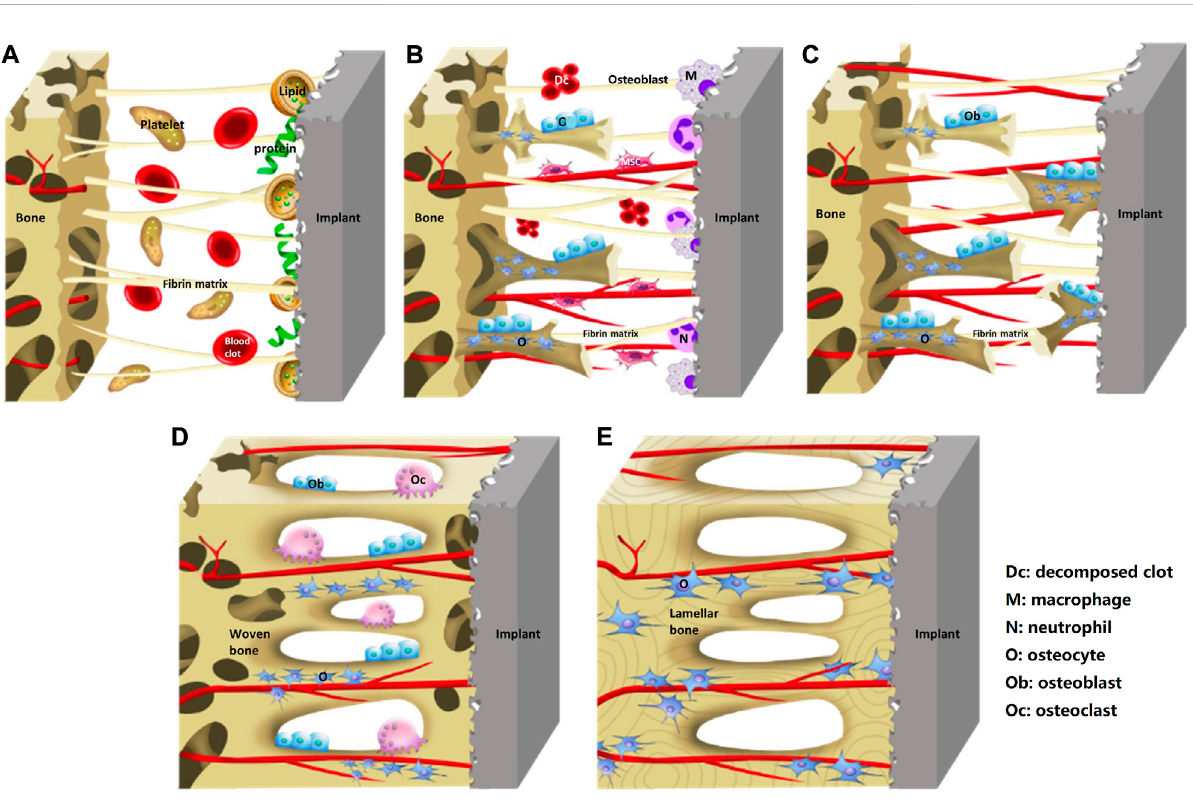
FIGURE 1 Schematic diagram of the process of implants osseointegration. (A) Blood clot and fi brin matrix formation. (B) Woven bone formation. (C) Distance osteogenesis and contact osteogenesis. (D) Newborn woven bones fi ll up the gap. (E) Woven bone matures into lamellar bone. Reprinted with permission (Liu et al., 2020a). Copyright 2019, the Authors. Published by